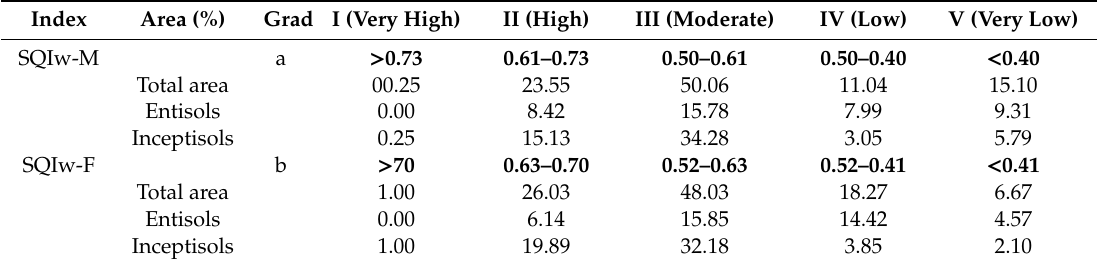
Table 6. Classification and percentage of soil quality grades for two soil quality indices (SQIw-M and SQIw-F) in two soil orders.